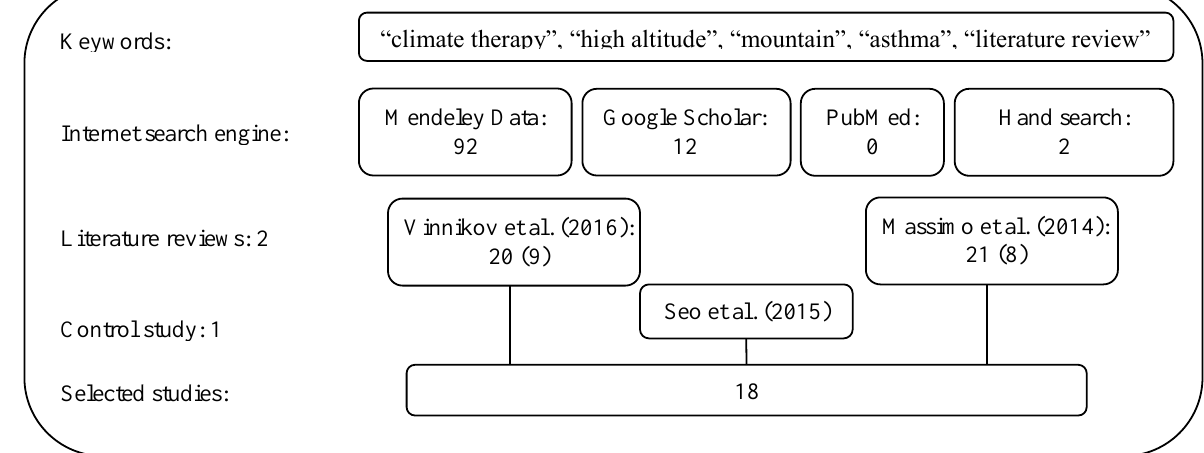
Figure 1. Flowchart of literature search and